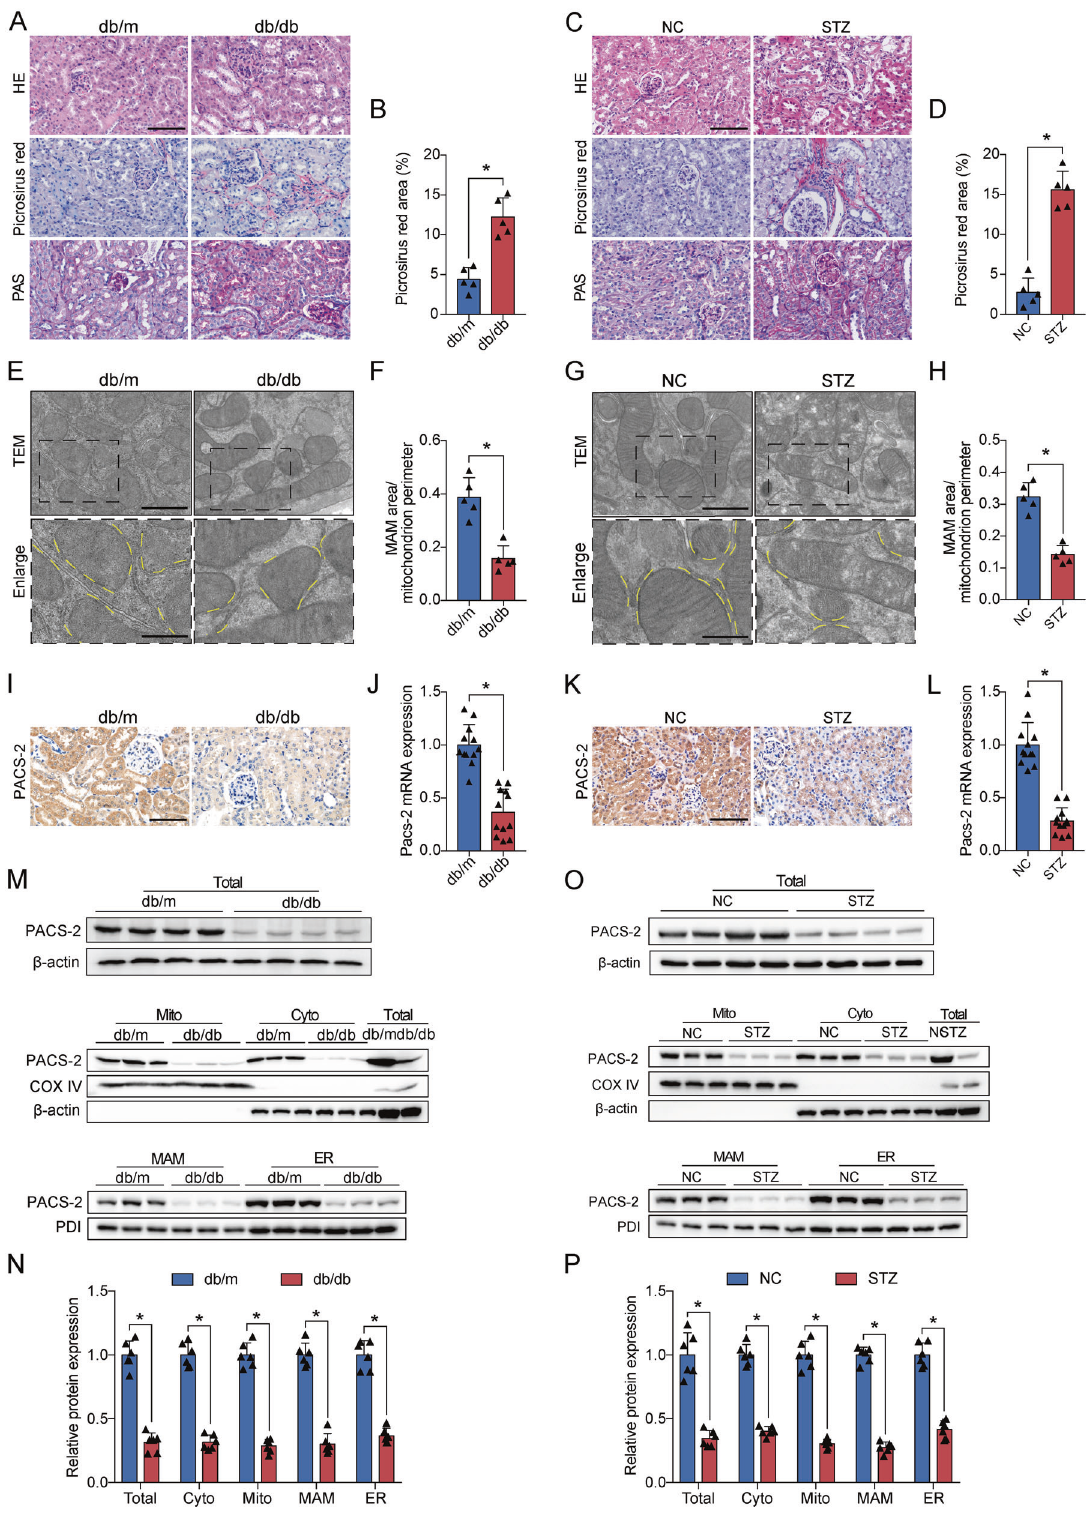
Fig. 1 Diabetes induced disruption of the MAM interface and decreased PACS-2 expression in the kidneys. A , C Representative images of HE, Picrosirius red, and PAS staining of kidney sections. Scale bar = 100 μ m. B , D Quantitative analysis of Picrosirius red staining in A and C . n = 5. E , G Representative TEM images showing the MAM area in the kidneys isolated from non-diabetic and diabetic mice. Yellow lines indicate the MAM interface. Scale bars = 1 μ m, inset scale bar = 500 nm. F , H Quantitative analysis of MAM area normalized to mitochondrion perimeter in E and G . n = 5. I , K Immunohistochemical staining of PACS-2 in the kidney sections. Scale bar = 100 μ m. J , L RT-PCR analysis of Pacs-2 mRNA levels in the kidneys. n = 12. M , O Western blot bands of PACS-2 proteins in total lysates and subcellular fractions isolated from mice kidneys. N , P Quantitative analysis of PACS-2 protein levels in M and O . n = 6 – 8. All data are expressed as mean ± SD. * P < 0.05.